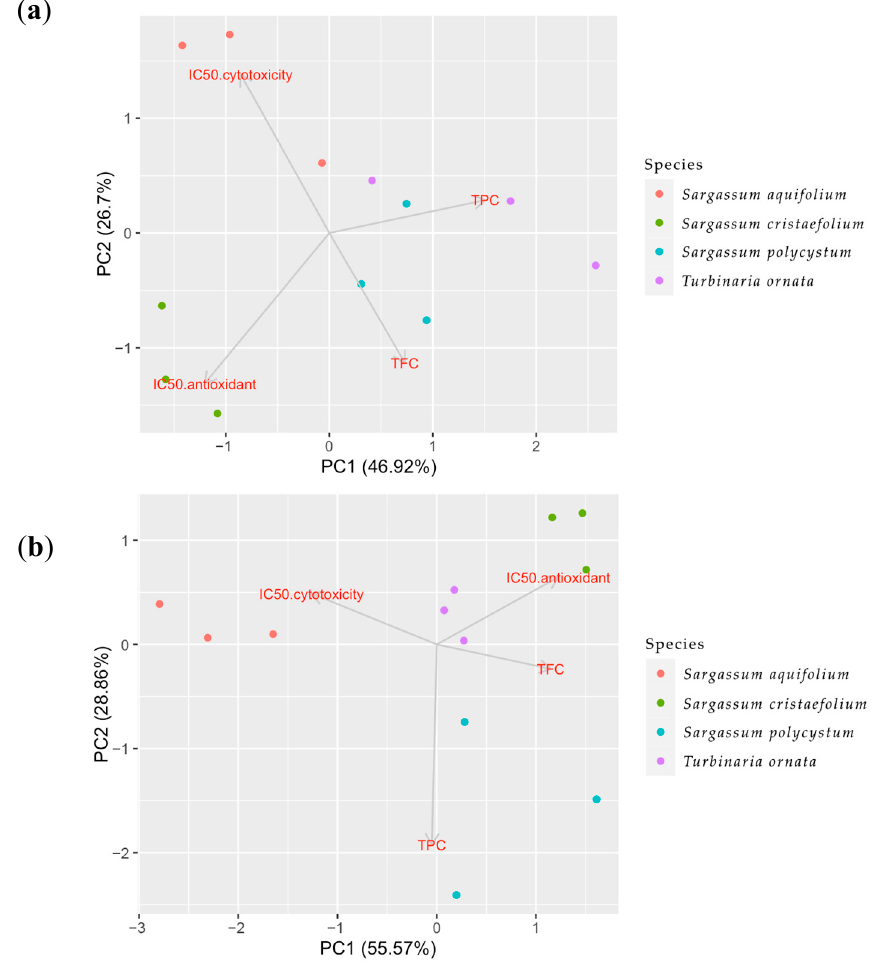
Figure 6. Principle Component Analysis (PCA) of multiple variables, total phenolic contents (TPC), total flavonoid contents (TFC), antioxidant and cytotoxicity towards B16-melanoma cells of the four brown algae species, Sargassum aquifolium , Sargassum cristaefolium , Sargassum polycystum and Turbinaria ornata , in two different extraction methods. ( a ) Sonication or ultrasonicated extract (UAE), ( b ) macerated extract.